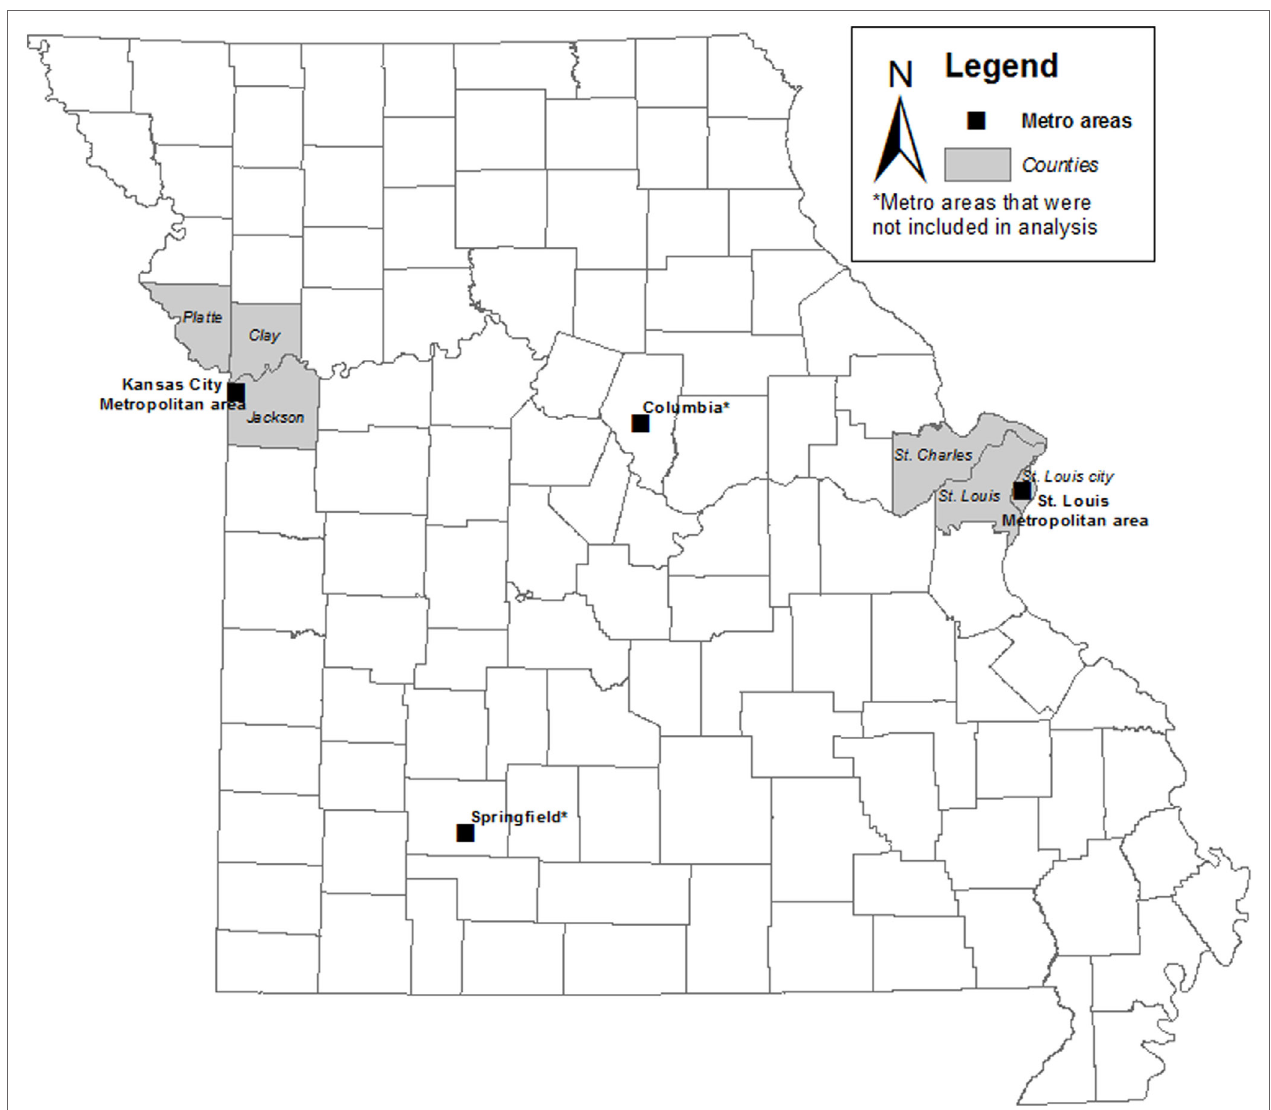
FigUre 1 | Map of Missouri by County with metropolitan areas sampled in the SHOW-ME